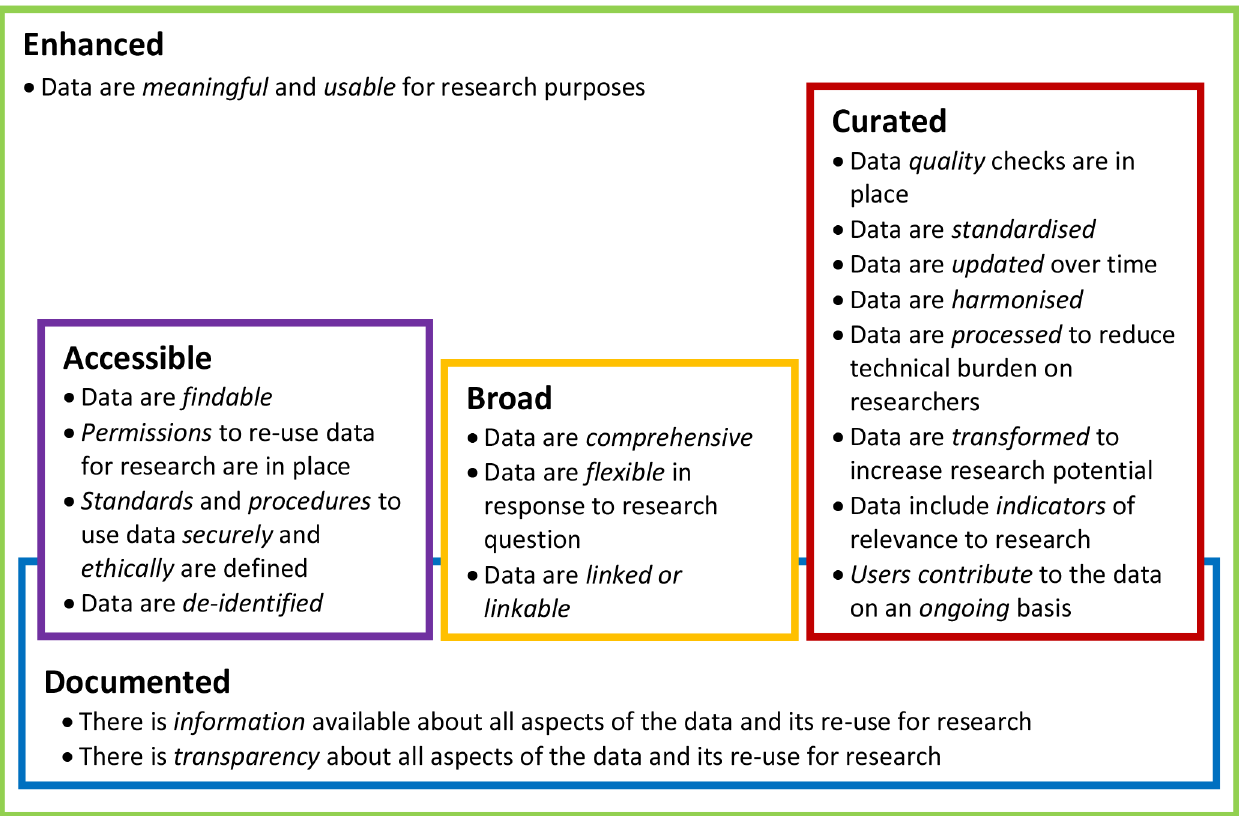
Figure 2: Key characteristics of research-ready administrative